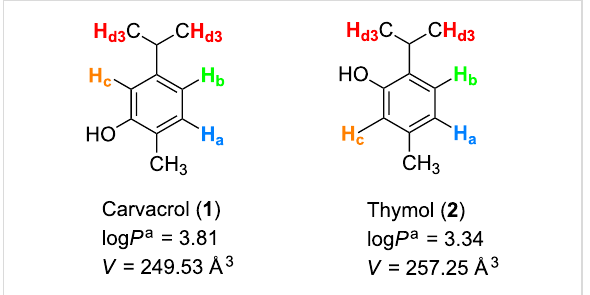
Figure 1: Chemical structures, log P values and molecular volumes ( V ) of carvacrol ( 1 ) and thymol ( 2 ). a http://www.molinspiration.com/cgi-bin/ properties. V = M / d NA, with M: molecular weight, d: density, NA: Avogadro’s